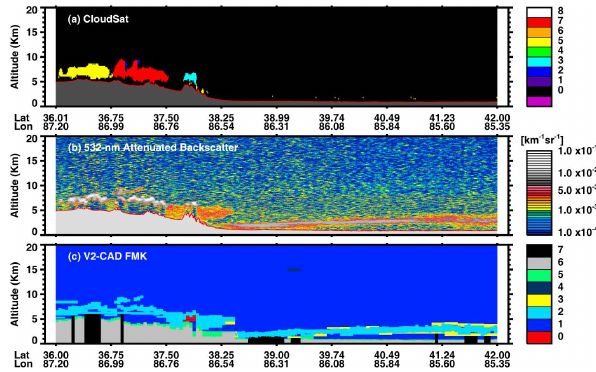
Fig. 4. Same as Fig. 2 except for 10 May